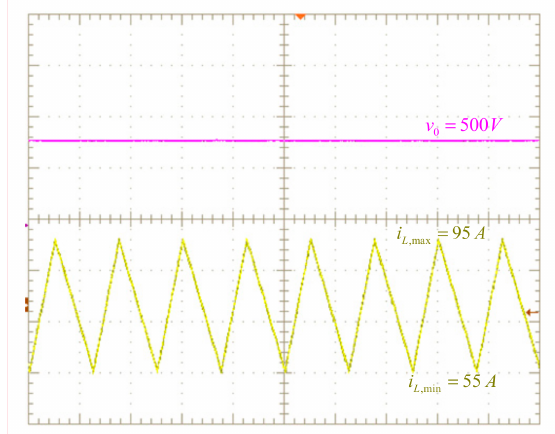
Figure 8. Output voltage and inductor current in the emulator with d = 0.6. i L , in yellow (15 A / div), v 0 , in magenta (15 V / div), and time (40 µ s /